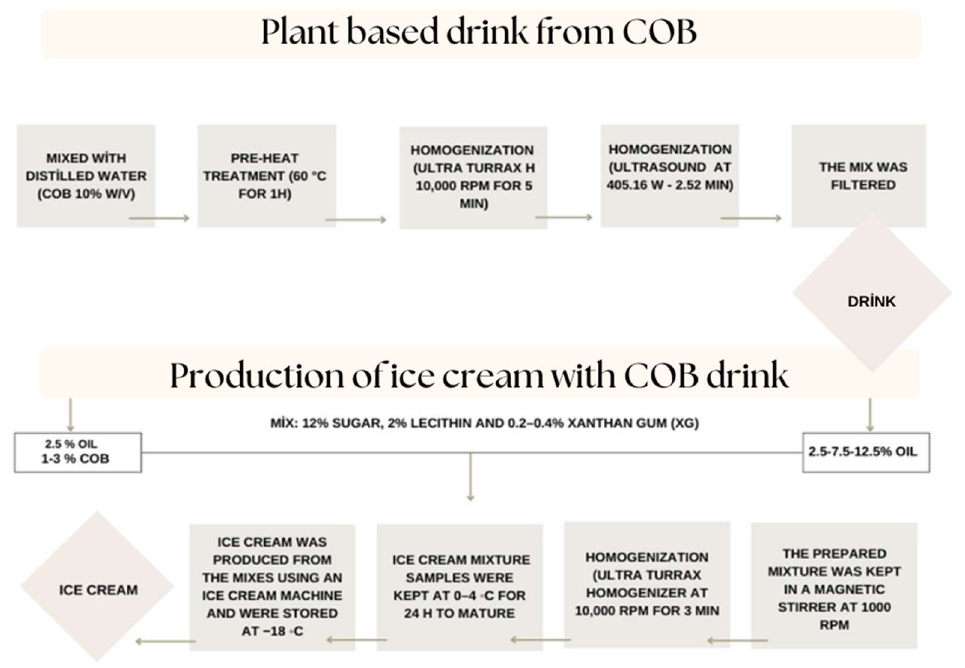
Figure 1. The flow sheet of production of coconut by-product drink and plant-based ice cream.